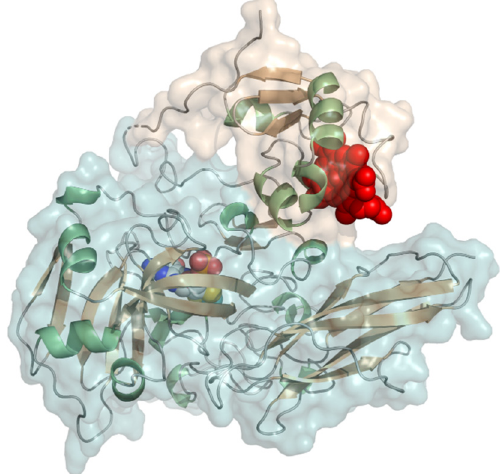
Figure 13. Crystal structure of Gallus gallus sulfite oxidase (PDB: 1SOX) with the Mo-domain colored in light cyan and the cytochrome domain in light red. The respective cofactors (Mo and heme) are shown as spheres.